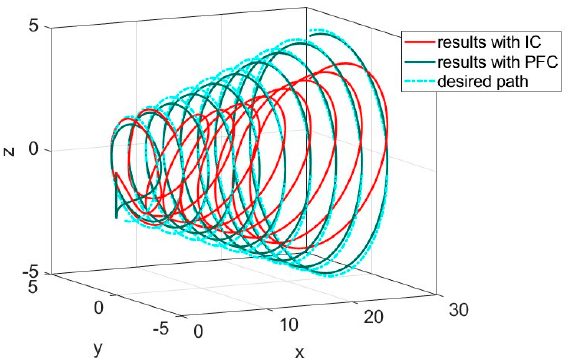
Figure 12. Comparison of three-dimensional phase plot between proposed fractional order controller (PFC) and integer order controller (IC).